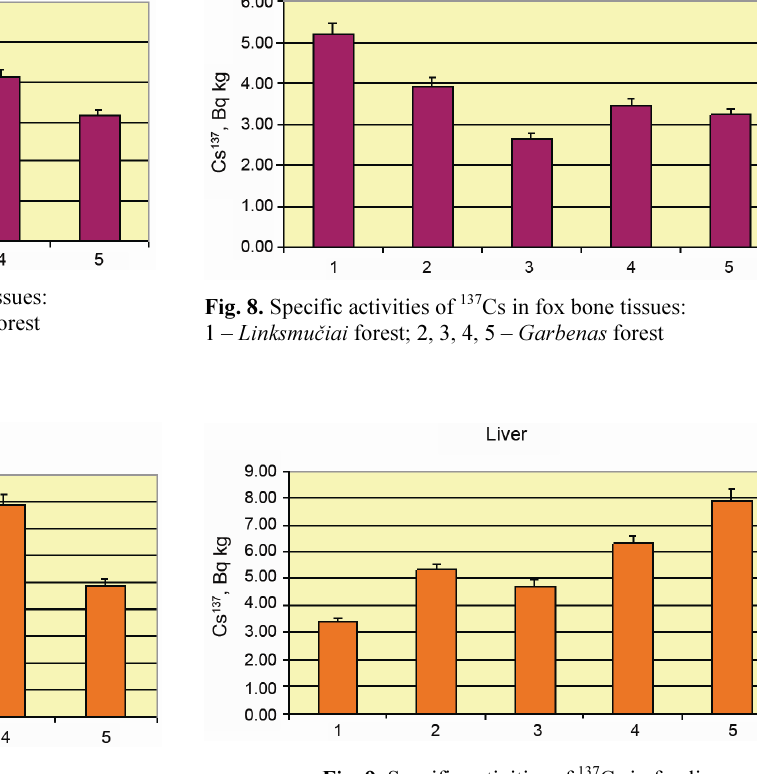
Fig. 9. Specific activities of